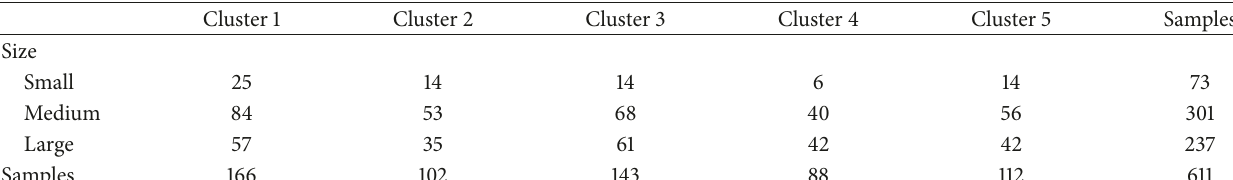
Figure 7: Partitioning of the SOM codebooks with 5 clusters (a) and the SOM plot sample hits (b). Table 9: Contingency table showing the distribution of project size among the clusters.